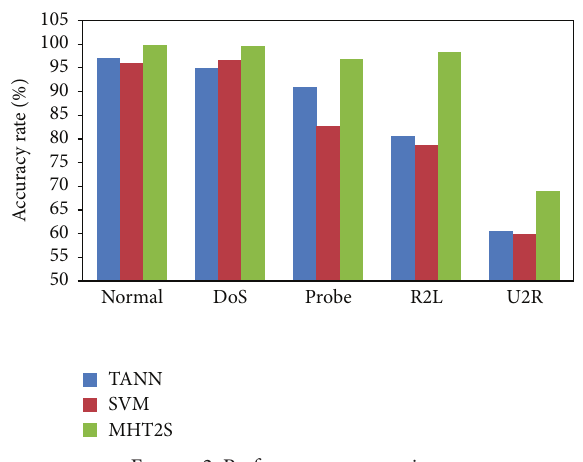
Figure 2: Performance